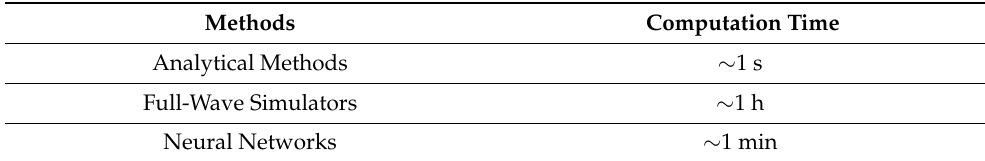
Table 1. Estimation of computation time for radiation pattern calculation with different methods> For general overview refer to Appendix